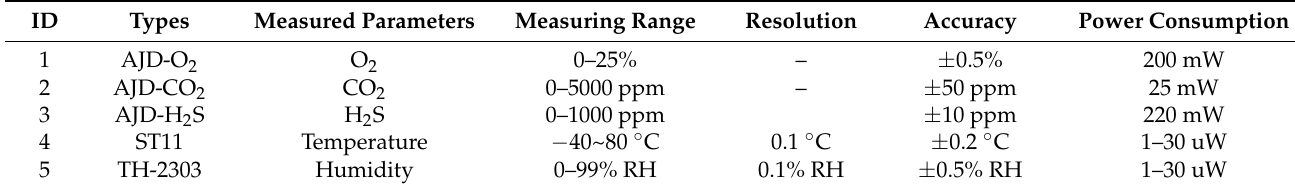
Table 1. Parameter performance of various sensors in chilled chicken